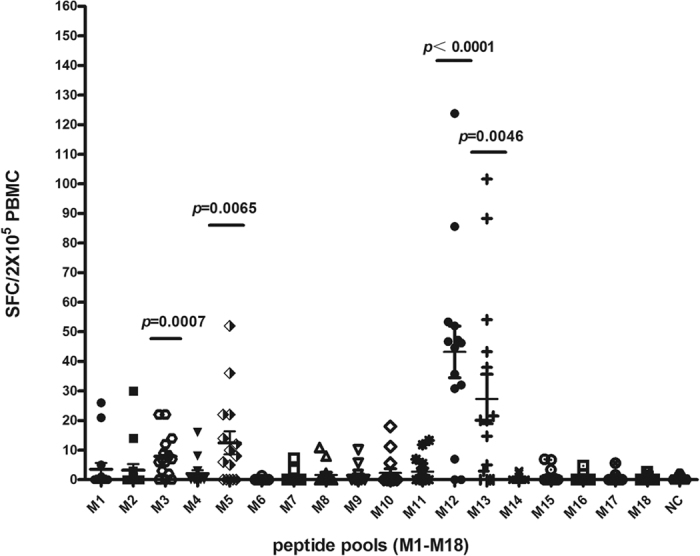
Positive peptide pools were screened by elispot assay through the signaling of SFC.The SFC values were significantly increased after co-culture of PBMCs with the peptide pools of M3 (P = 0.0007 versus control group), M5 (P = 0.0065 versus control group), M12 (P < 0.0001 versus control group) and M13 (P = 0.0046 versus control group), no significant difference were seen in other peptide pools (n = 15).